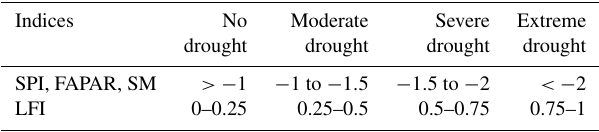
Table 1. Drought indices and their associated drought classes. SPI, FAPAR, SM, and LFI are, respectively, Standardised Precipitation Index, Fraction of Accumulated Photosynthetically Active Radia- tion, Soil Moisture, and Low Flow